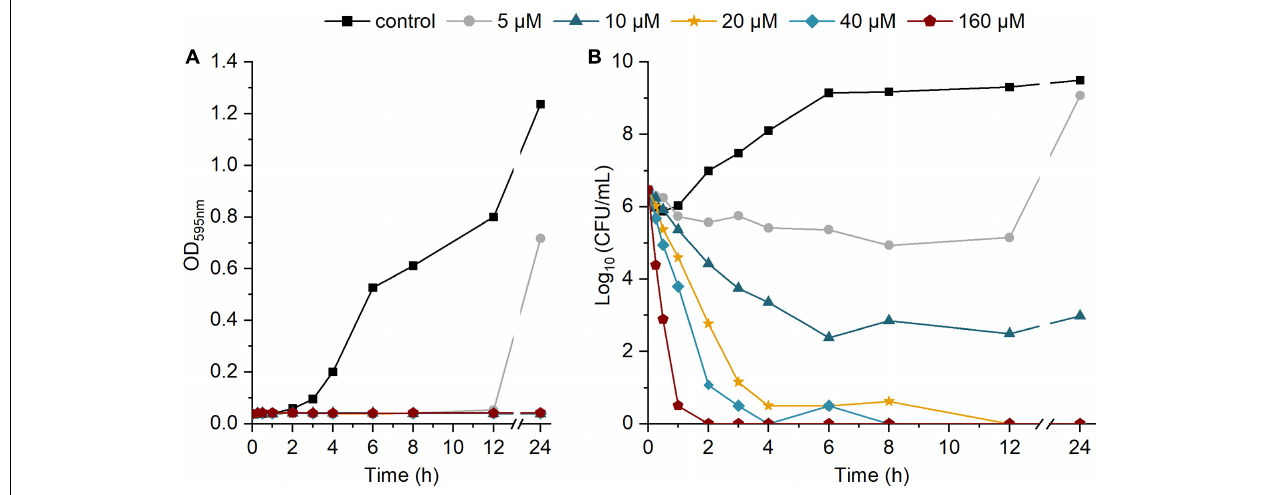
FIGURE 3 | Time-kill kinetic of different concentrations of etrasimod against Staphylococcus aureus ATCC 25923 over 24-h incubation: (A) OD 595 of the bacterial culture over time; (B) Log 10 of the CFU/mL in the bacterial culture over time. Results are the average of four biological repetitions, each with one replicate per